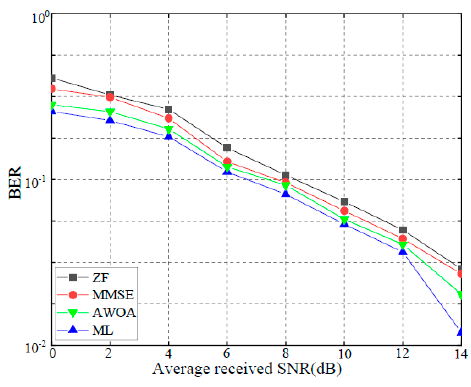
Figure 12. BER in 4*8 MI-MIMO.